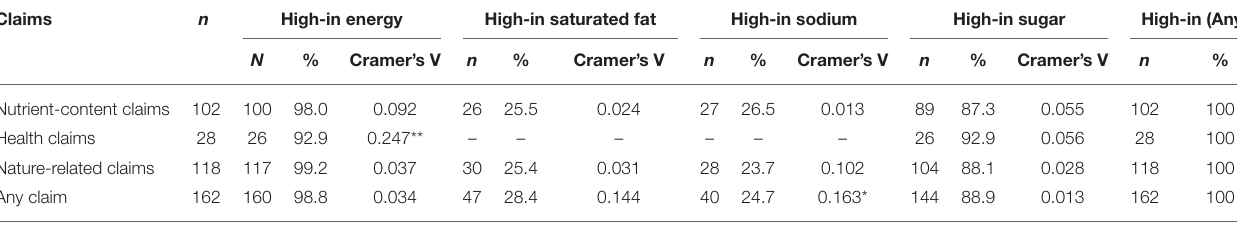
TABLE 2 | Percentage of Ready-to-Eat cereal packages with claims that are high in critical nutrients. Claims n High-in energy N % Cramer’s V